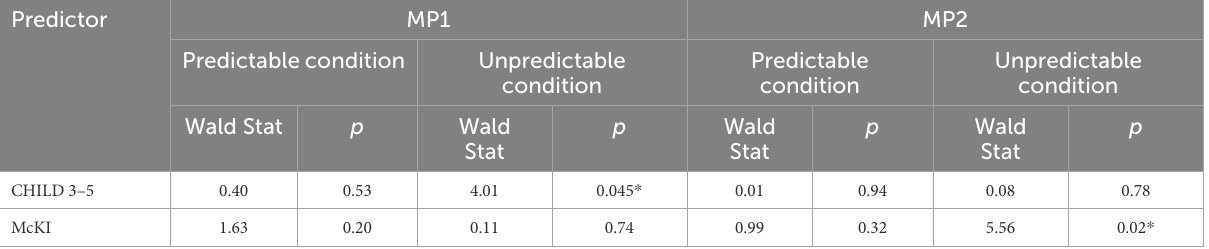
TABLE 4 Effect of metacognition scores on goal change scores (logistic regression).